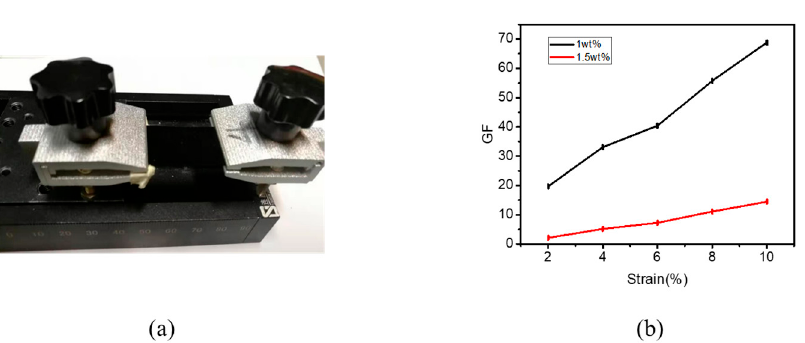
Figure 3. ( a ) Uniaxial stretching fixture. ( b ) GF (gauge factor) values of 1 wt. % film and 1.5 wt. % film during uniaxial stretching.